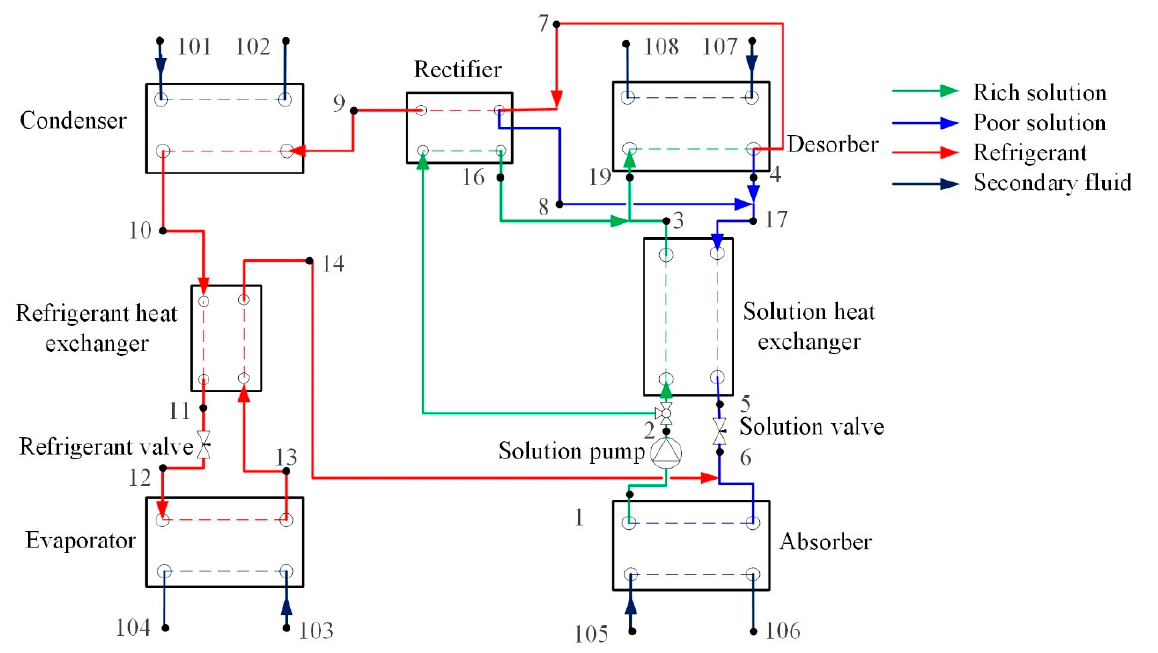
Figure 4. Flow diagram of ammonia/water absorption cycle with bypassed rich solution.